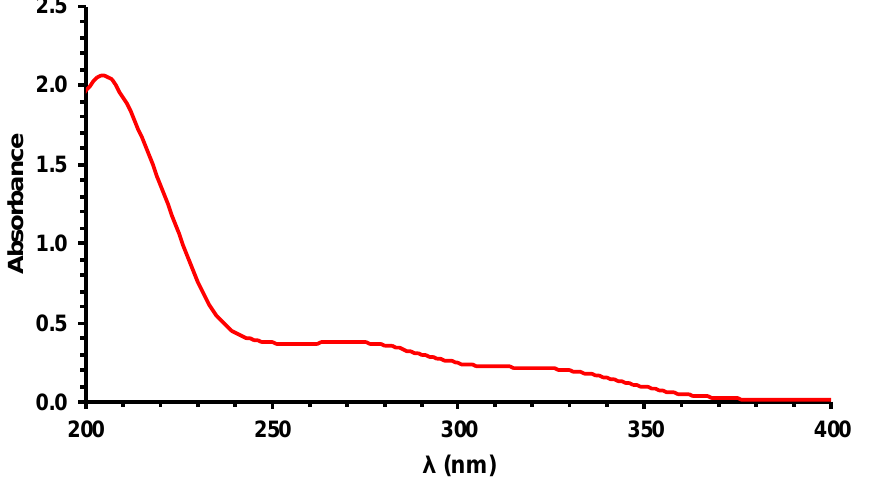
Figure 2. UV absorption spectrum of white wine (diluted 1:20).